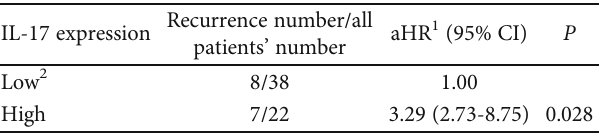
Table 3: Association of IL-17 expression with disease recurrence among the patients with LC ð n = 60 Þ